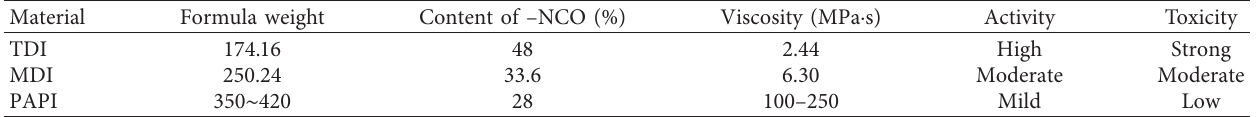
Table 1: Performance comparison table of